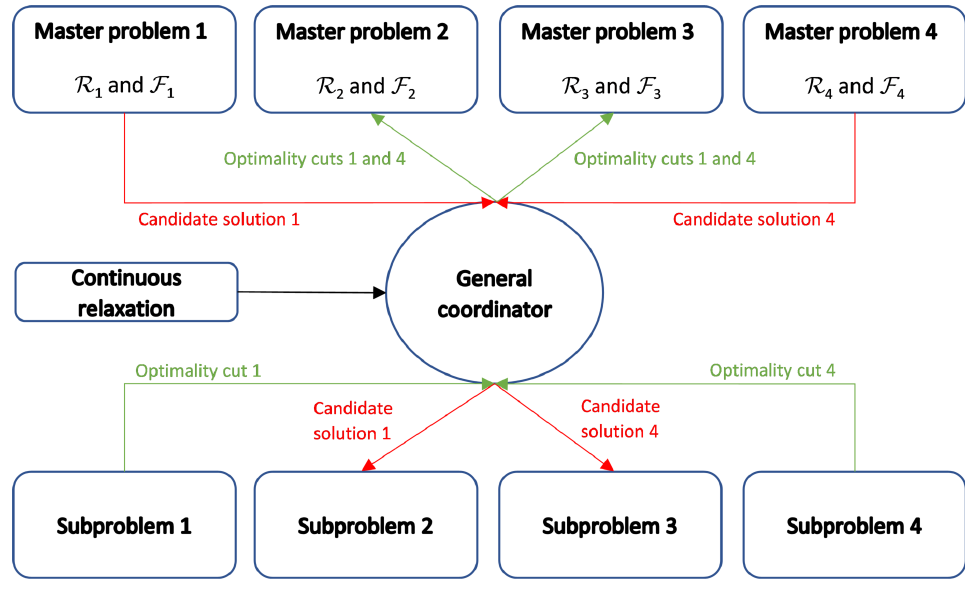
Figure 5. Flowchart of algorithm